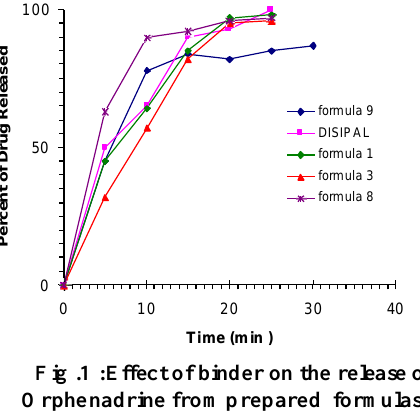
Fig .1 :Effect of binder on the release of